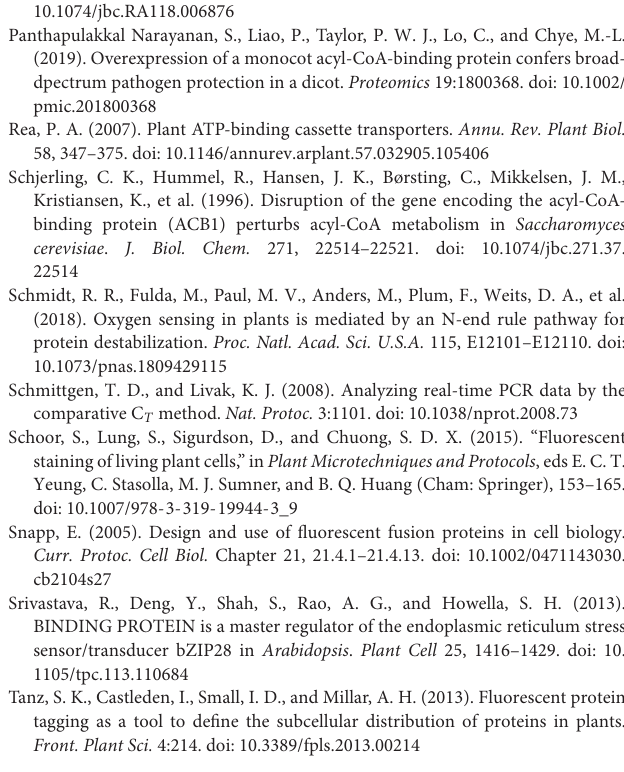
Frontiers in Plant Science |